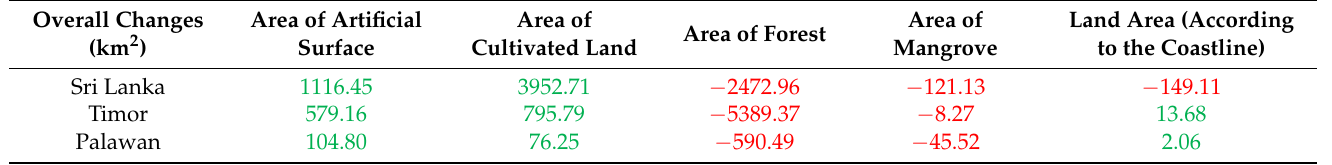
Table 3. Overall changes in area for the main land cover types for three tropical islands from 1990 to